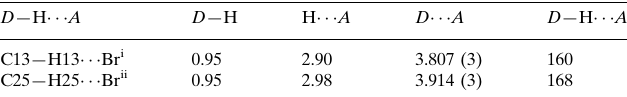
Hydrogen-bond geometry (A˚ , (cid:1)